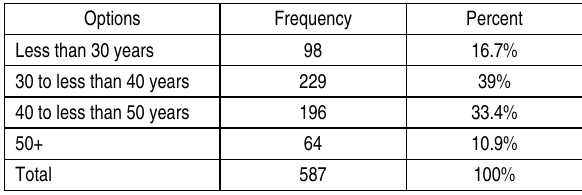
Table 2. Study sample distribution according to